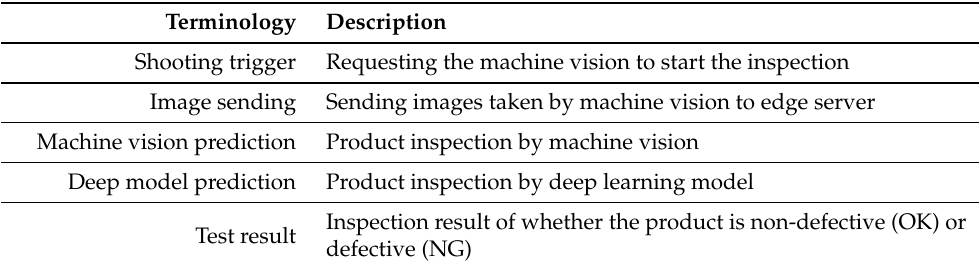
Table 3. Explanation of